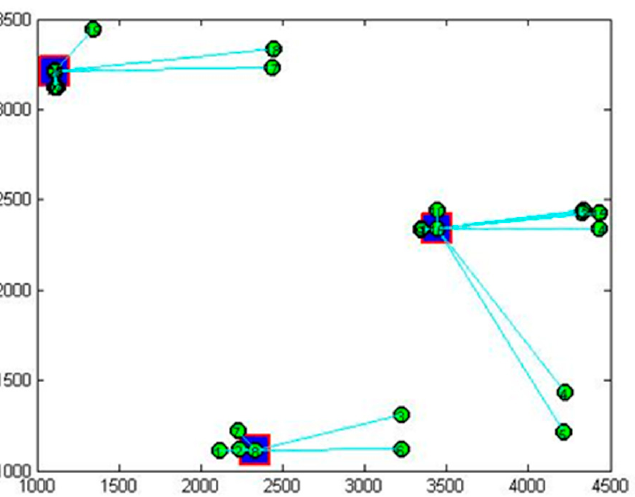
Figure 10. Key nodes in effect of Chinese outward FDI on wellbeing of OECD countries.